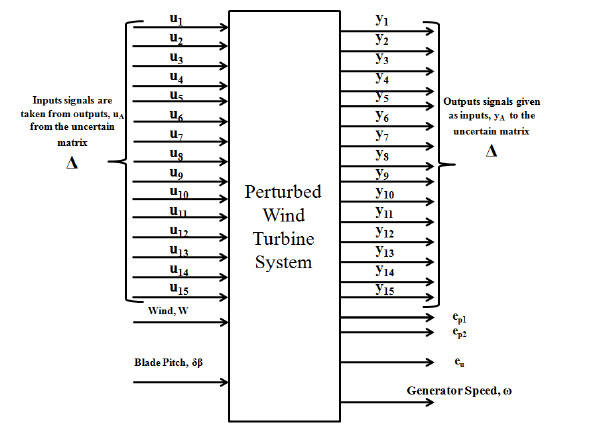
the dashed rectangular box. The H ∞ norm inequality